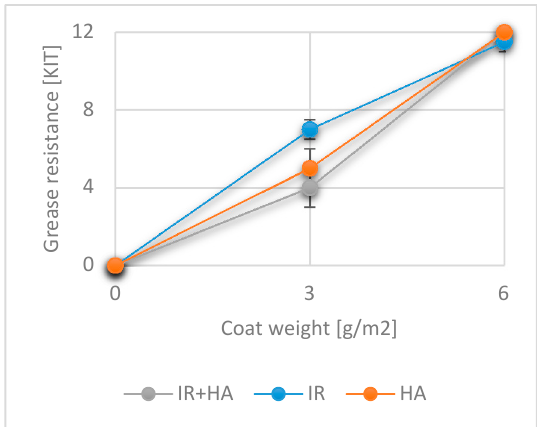
Figure 7. Grease resistance as measured with the KIT test for uncoated substrates and coated substrates with one and two layers of chitosan. (KIT, n = 6).